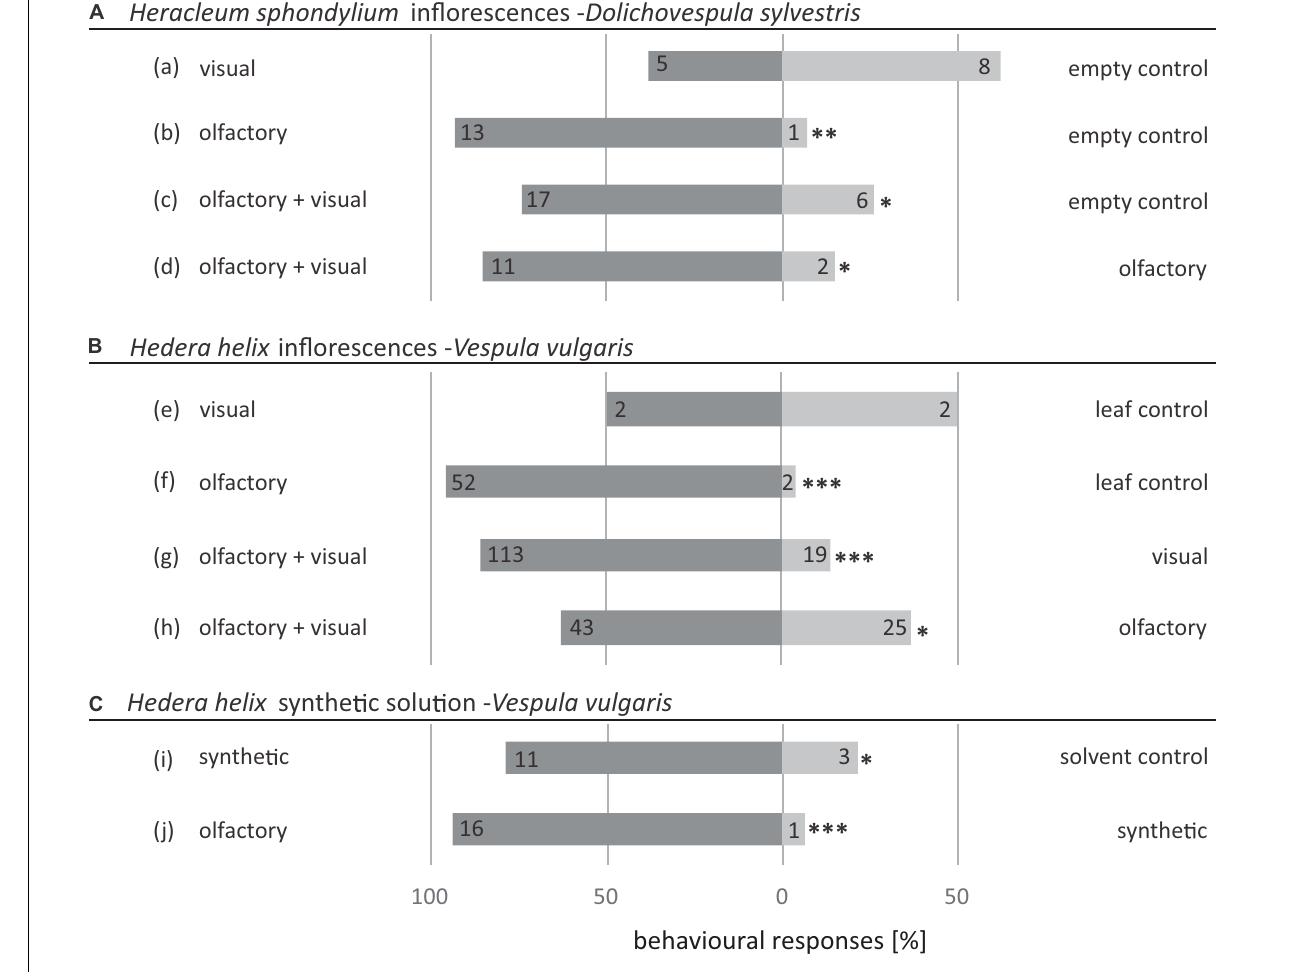
FIGURE 5 | Attractiveness of (A) olfactory and visual cues of inflorescences of Hedera helix to Vespula germanica wasps, (B) synthetic Hedera helix scent samples to Vespula germanica wasps, and (C) olfactory and visual cues of inflorescences of Heracleum sphondylium to Dolichovespula sylvestris wasps. The synthetic solution consisted of EAD-active compounds of H. helix ( Table 2 ). Non-flowering Hedera helix twigs were used as a leaf control (a,b). Mineral oil was used as a solvent control (e). Numbers inside the bars indicate absolute numbers of responding wasps (exact binomial test; * p < 0.05, ** p < 0.01, *** p <